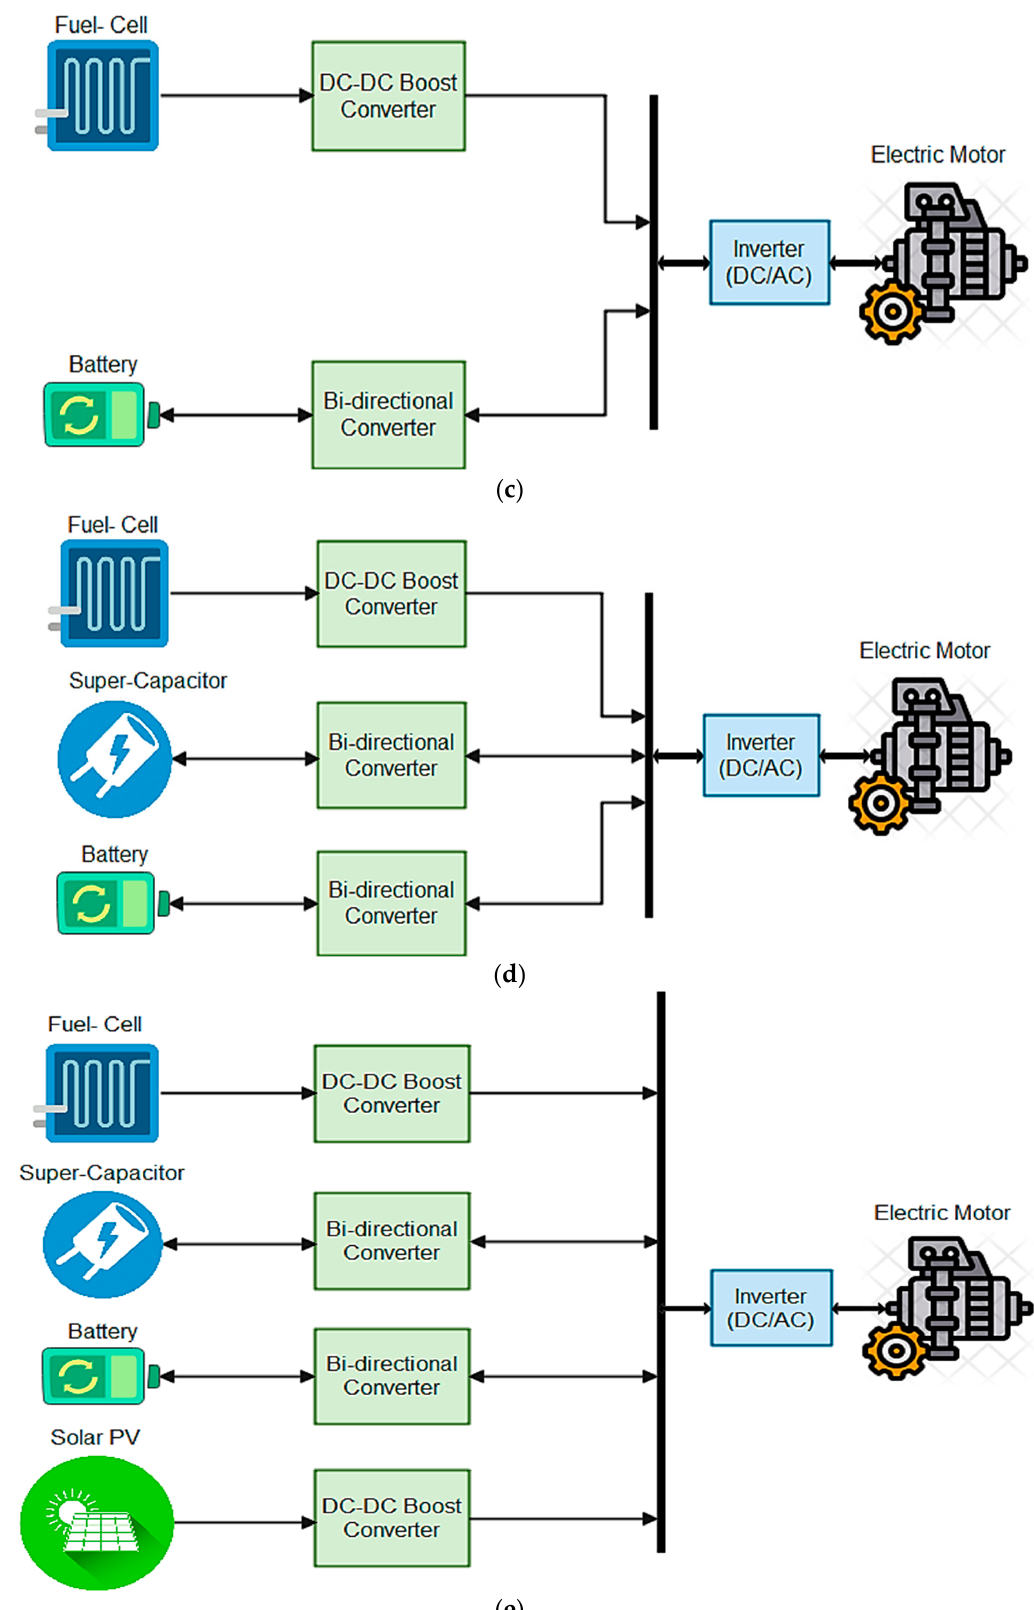
Figure 4. FCEV power source con fi gurations: ( a ) FC only; ( b ) FC-SC; ( c ) FC-Ba tt ery; ( d ) FC-SC-Bat- tery; ( e ) FC-SC-PV-Ba tt ery.